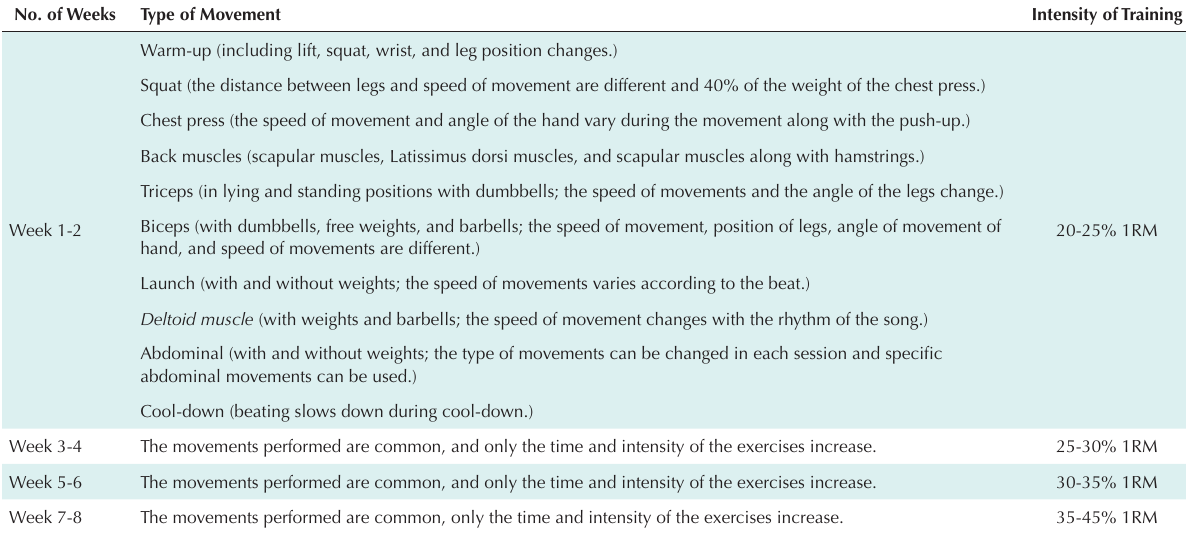
Table 1. Schedule of Incremental Pump Body Training No. of Weeks Type of Movement Intensity of Training